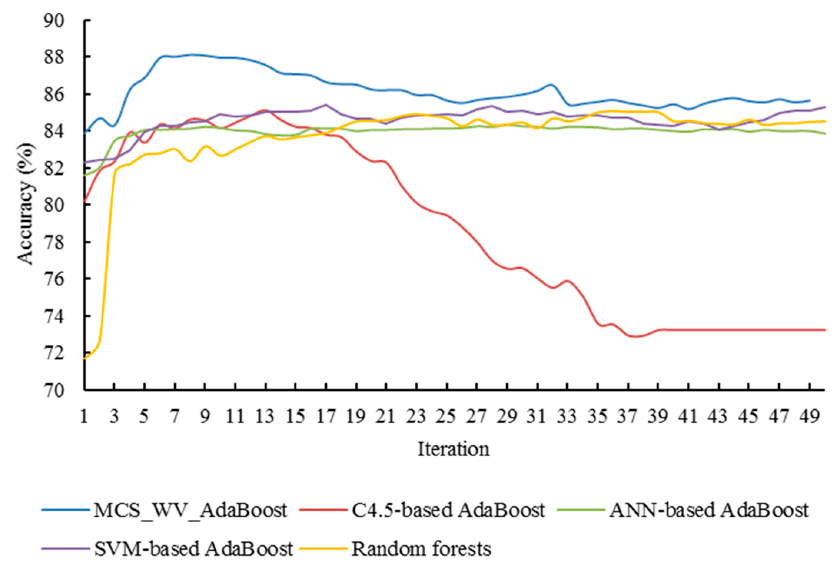
Figure 8. Classification accuracy improvements of MCS_WV_AdaBoost using three base classifier training algorithms: C4.5, ANN, and SVM.